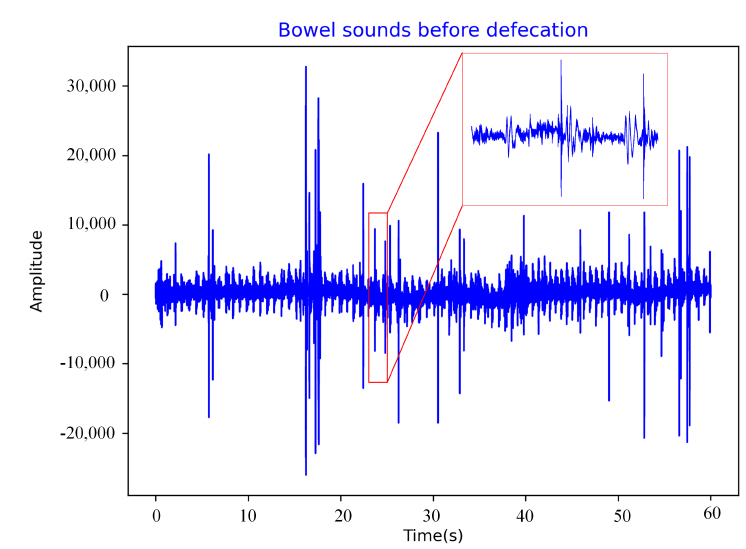
Figure 3. Normal bowel sounds.